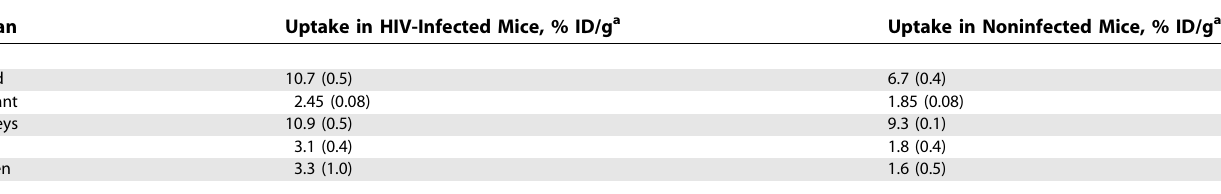
Table 1. Biodistribution of 188 Re-246-D mAb in thy/liv-SCID-hu Mice Uninfected and Infected with HIV Examined 18 h after Intraperitoneal Injection Organ Uptake in HIV-Infected Mice, % ID/g